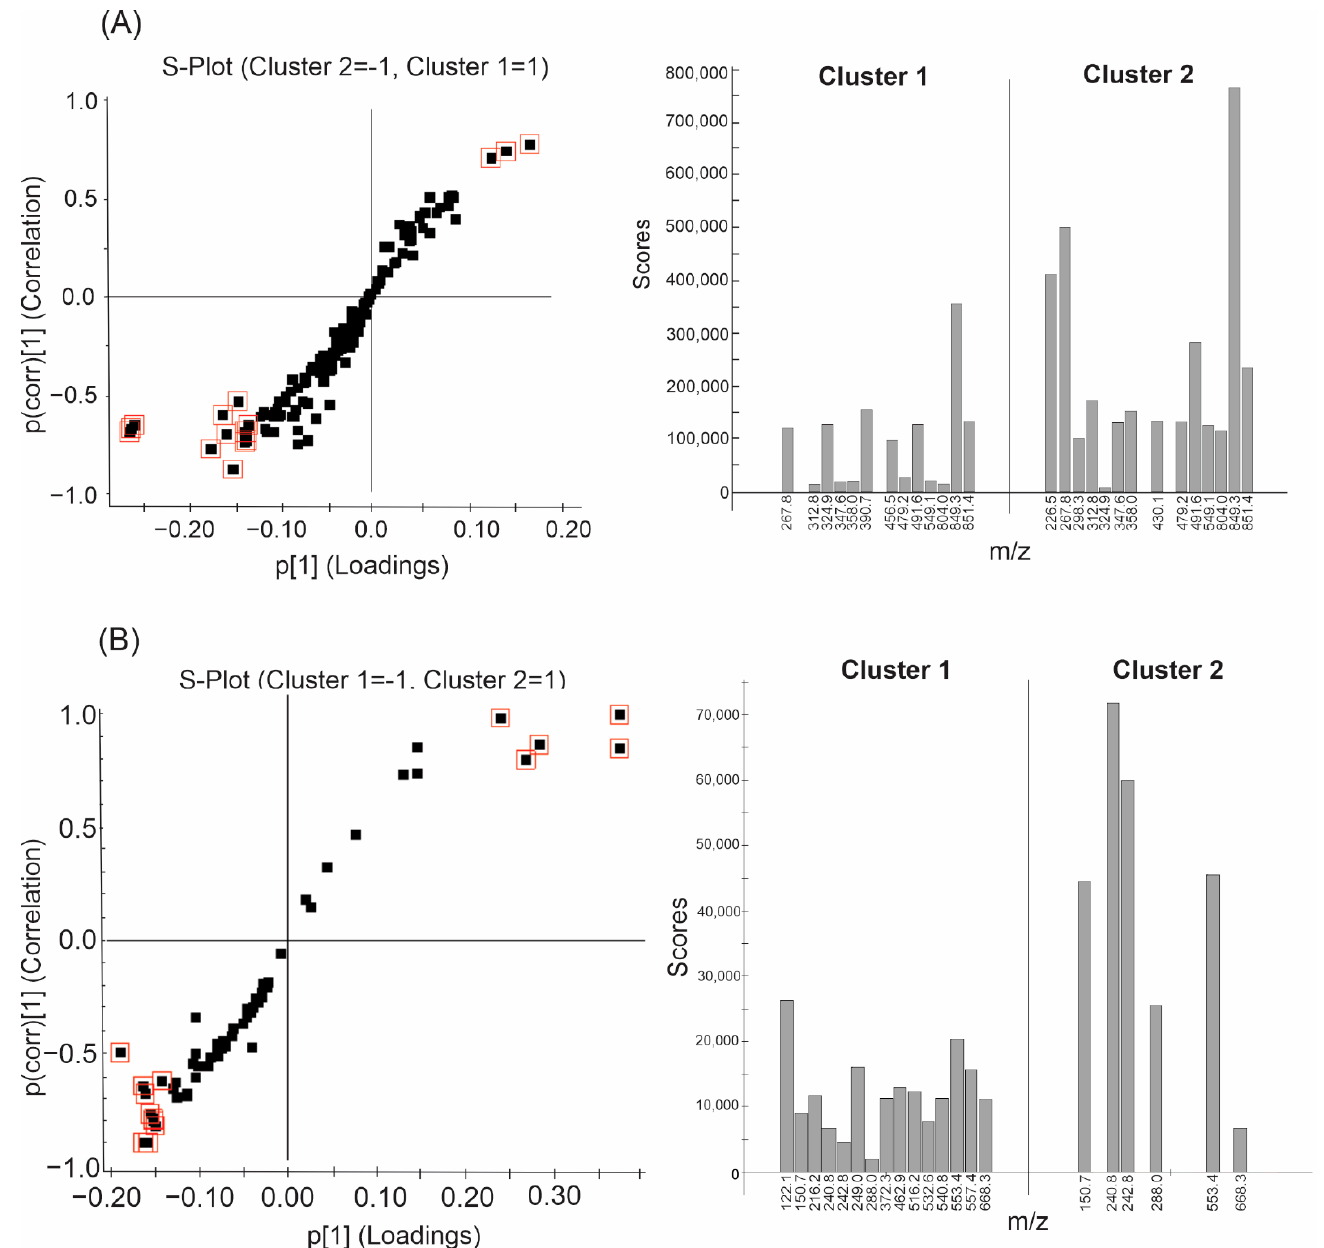
Figure 5. S-plots (left) and normalized mean ion intensities (right) for ions selected in (A) positive mode and (B) negative mode. The highlighted squares correspond to ions with the highest correlation values (VIPs) in their respective clusters; they are highlighted in the histograms to the right of each S-plot. Ions that are repeated in both samples but stand out in relation to their observed intensities are observed in both clusters. Cluster 1: pH < 7; Cluster 2: pH ≥ 7.